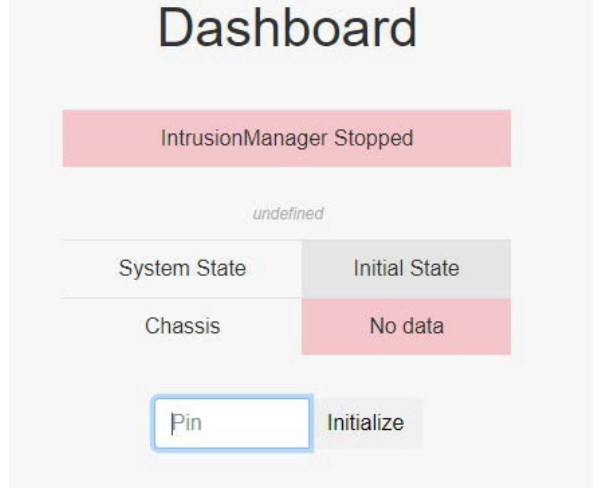
Figure 26. Initial state.